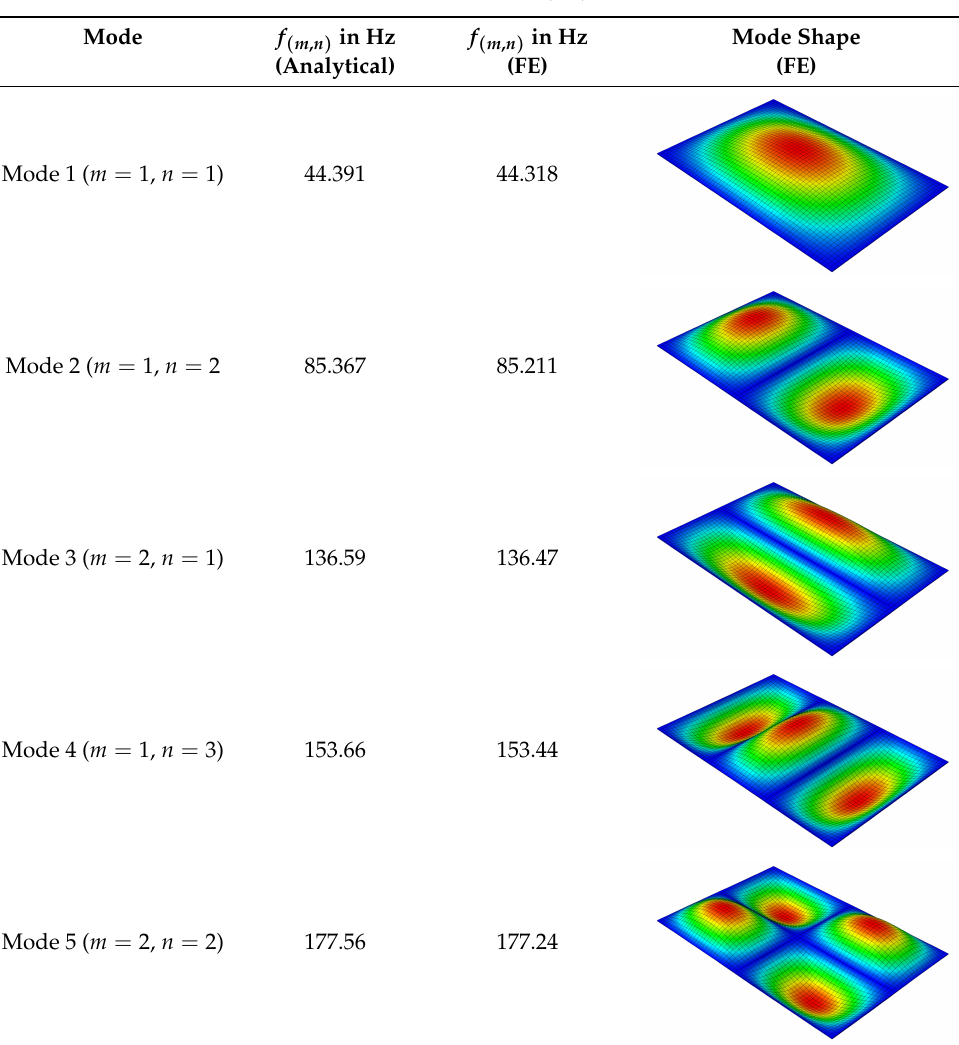
Table 3. Free vibration modes with natural frequencies f ( m , n ) below 200